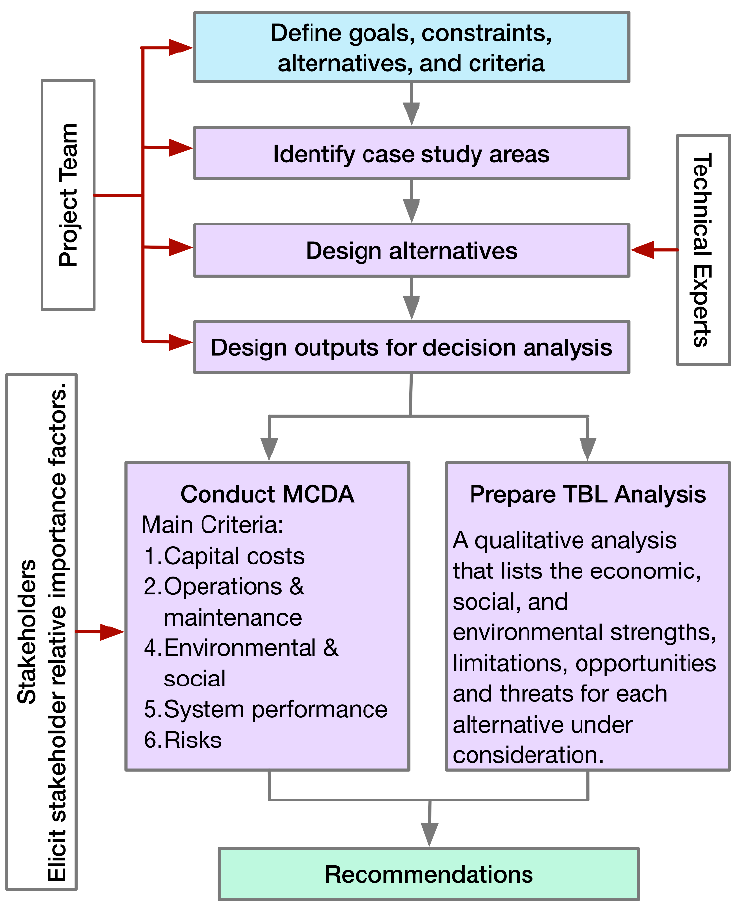
Figure 1. Original Figure 1. Original approach.